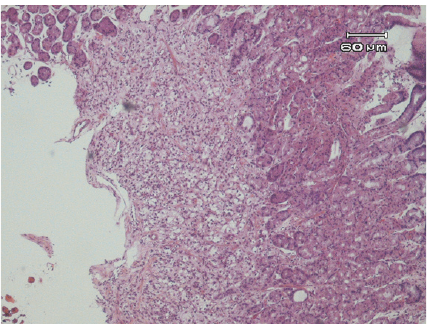
Figure 2: Gastric ulcer biopsy showing clear cell RCC consistent with metastatic RCC to